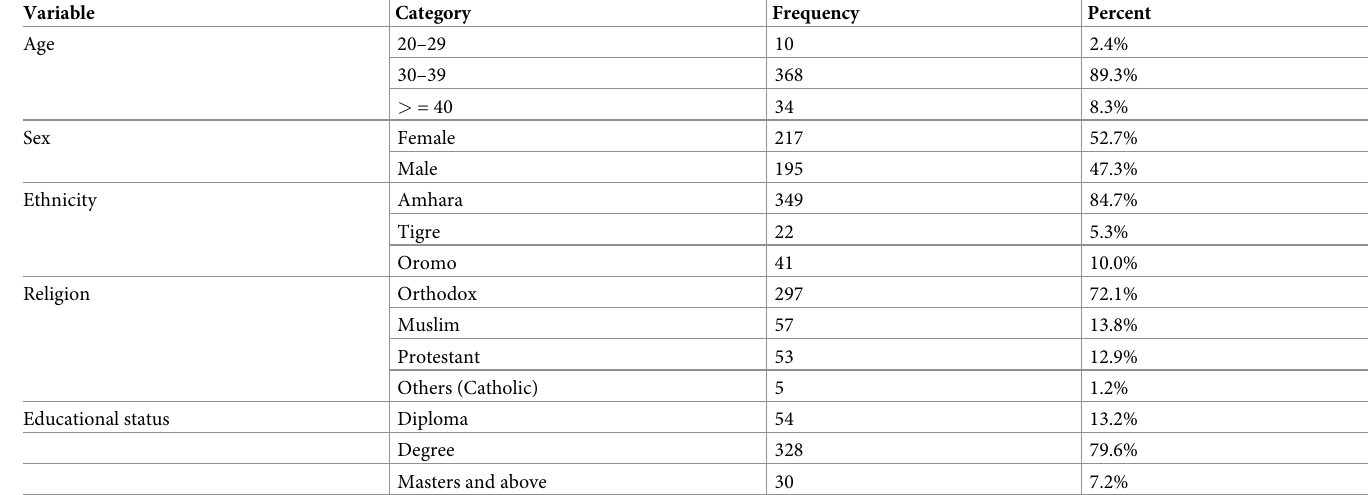
Table 1. Socio-demographic characteristics of intensive care unit nurses in Amhara Region public hospitals, Amhara, Ethiopia, 2020 (N =